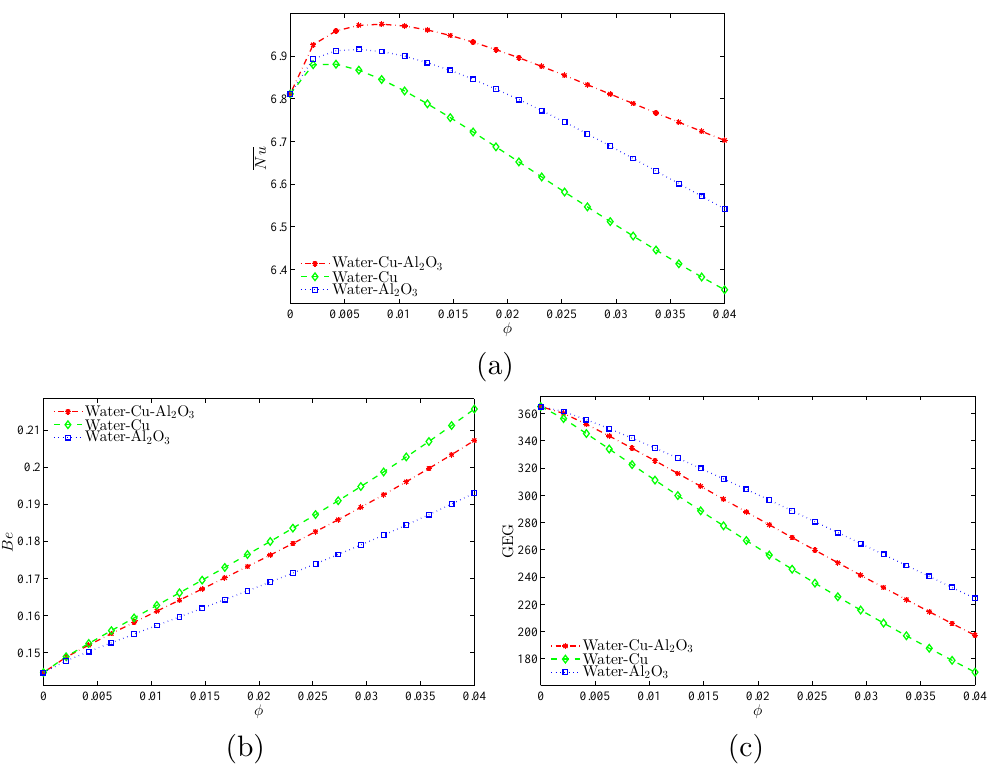
Figure 8. The evolution of the average characteristic as a function of various volume fractions of nanoparticles φ for the base fluid, nanofluids and hybrid nanofluids, ( a ) average Nusselt number ( Nu ), ( b ) Bejan number ( Be ), and ( c ) the global entropy generation (GEG) when Ra = 10 5 and D =